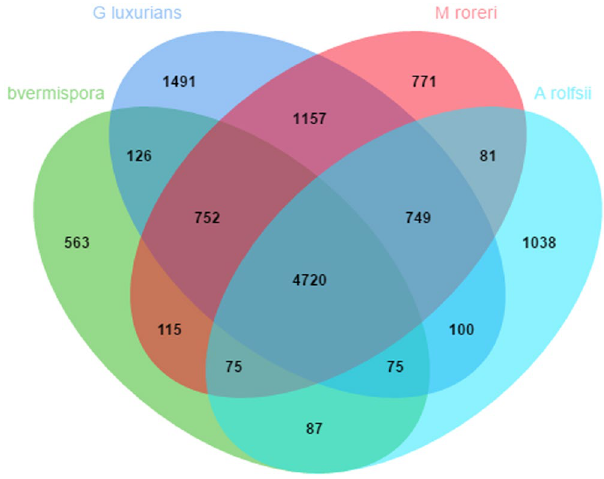
Figure 9. Venn diagram of orthologous gene family among the four fungal